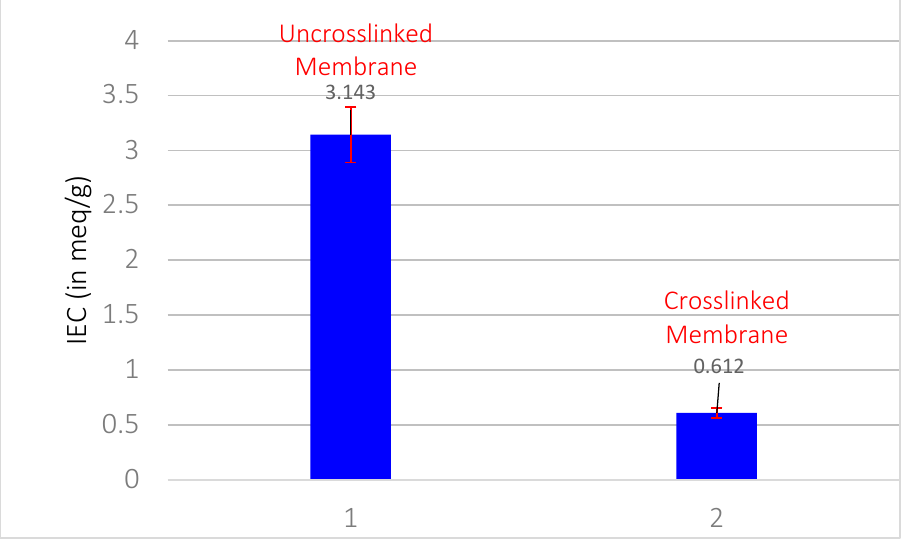
Figure 11. Ion exchange capacity of the plain and crosslinked membranes.